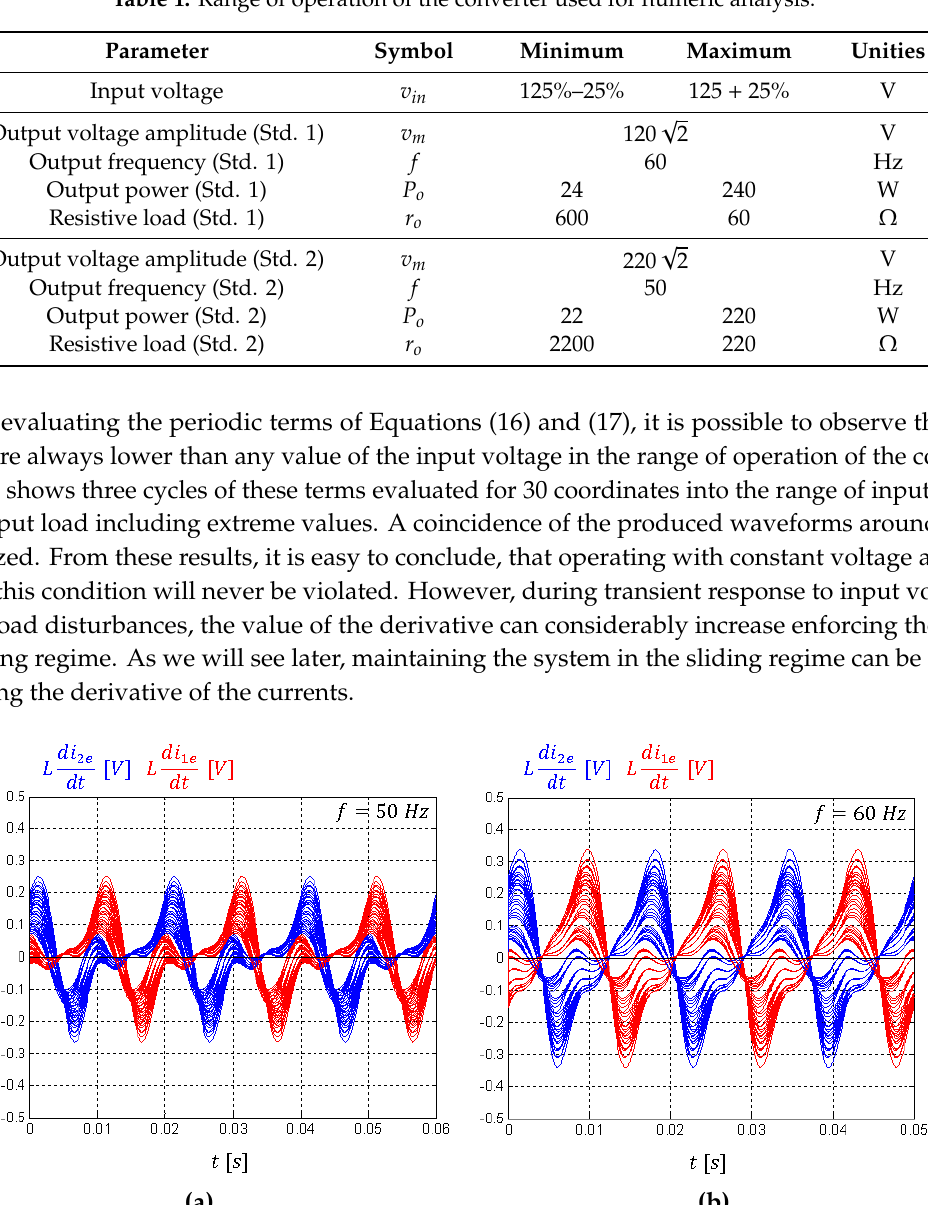
Table 1. Range of operation of the converter used for numeric analysis.